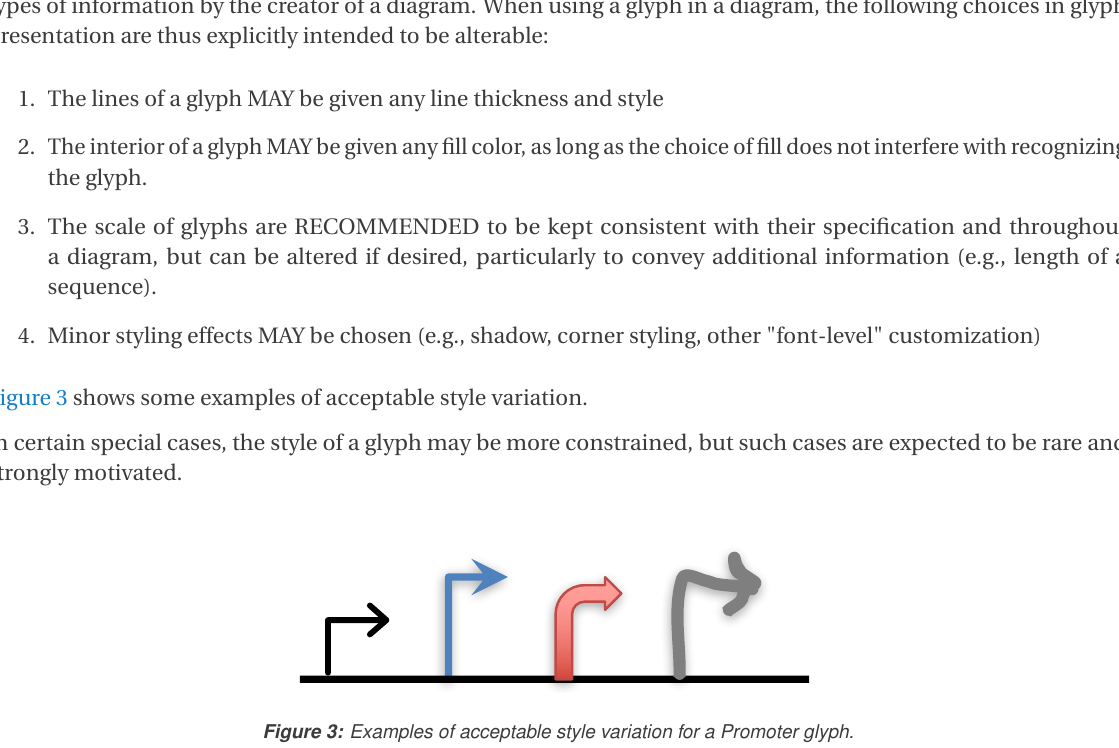
Figure 3: Examples of acceptable style variation for a Promoter